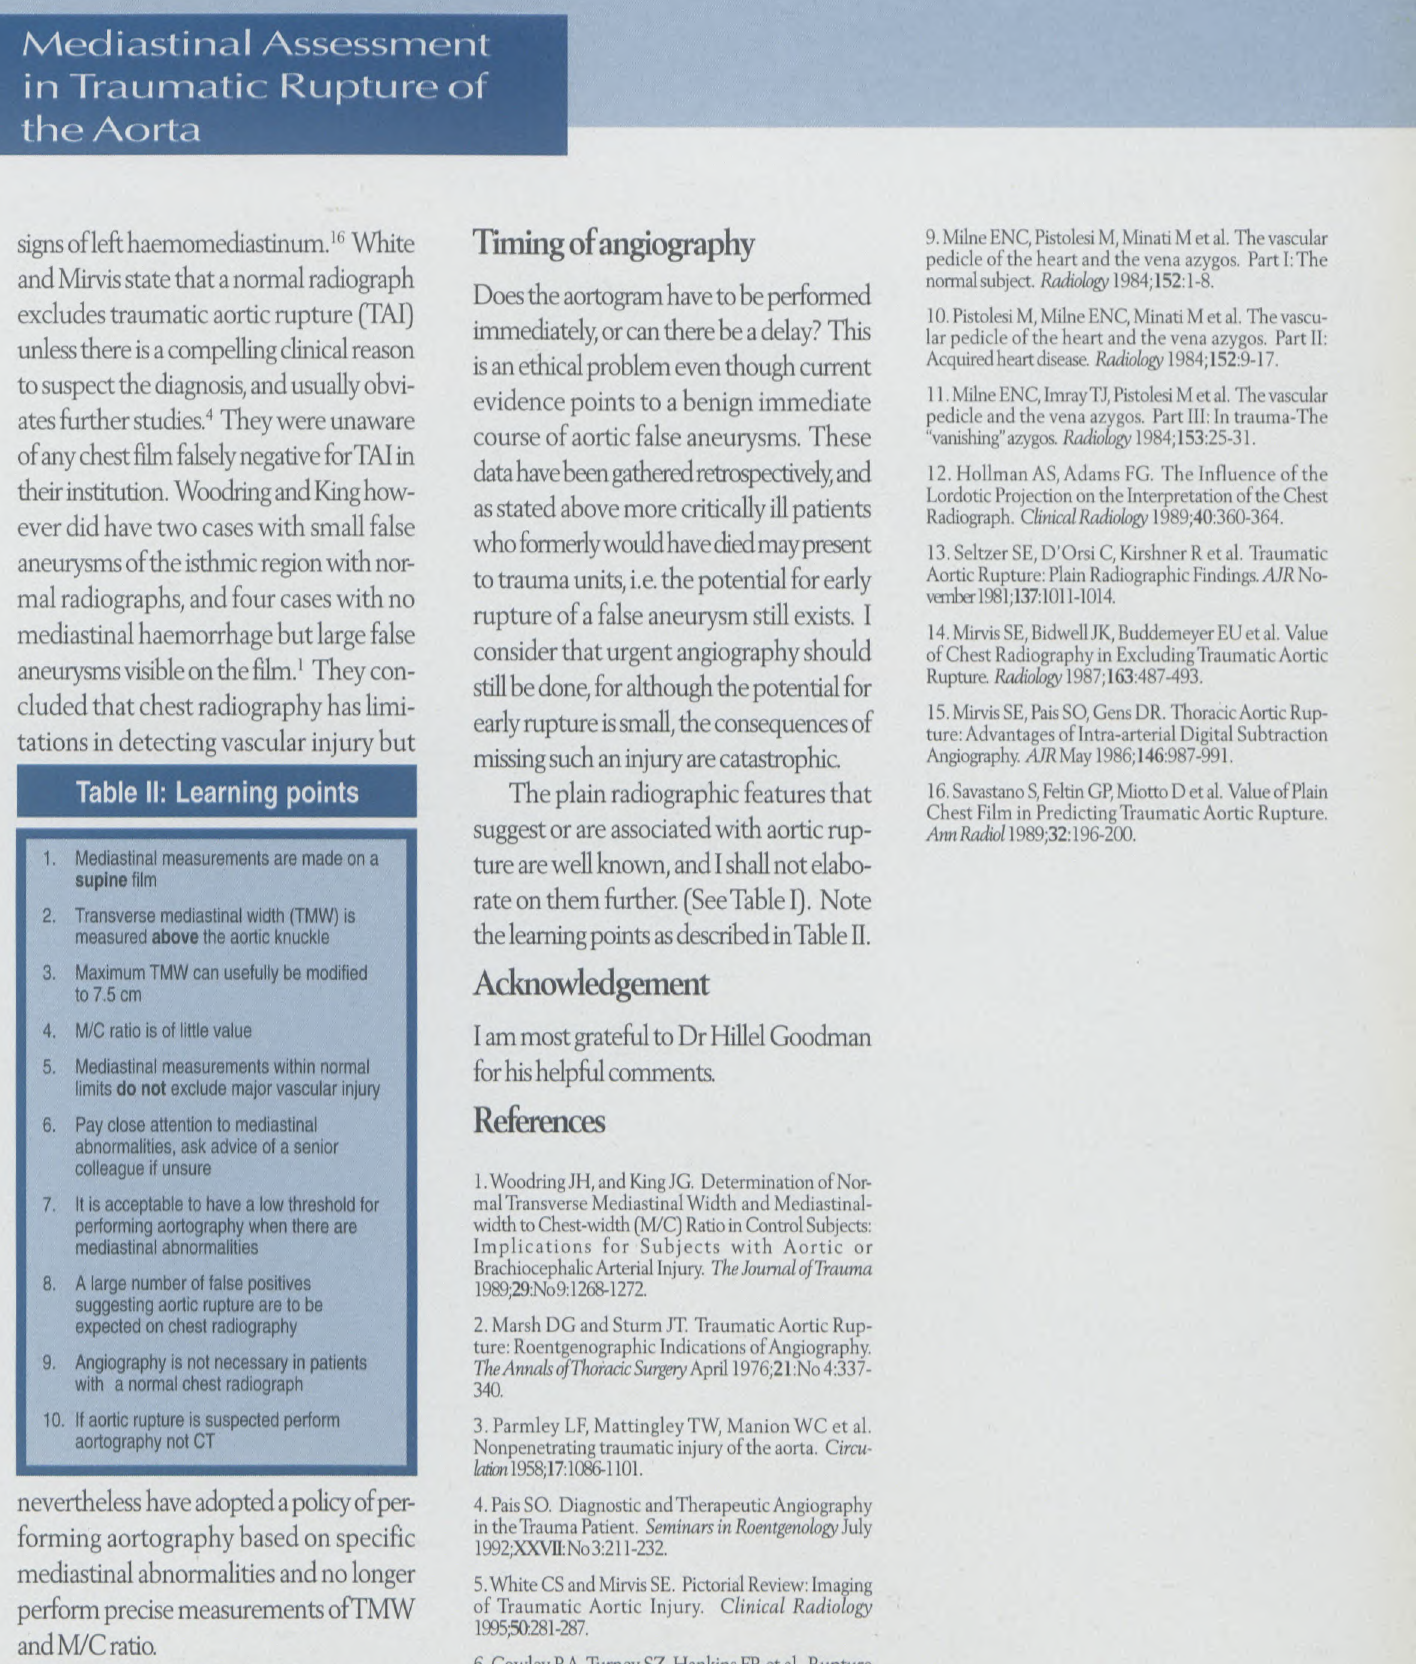
Table II: Learning